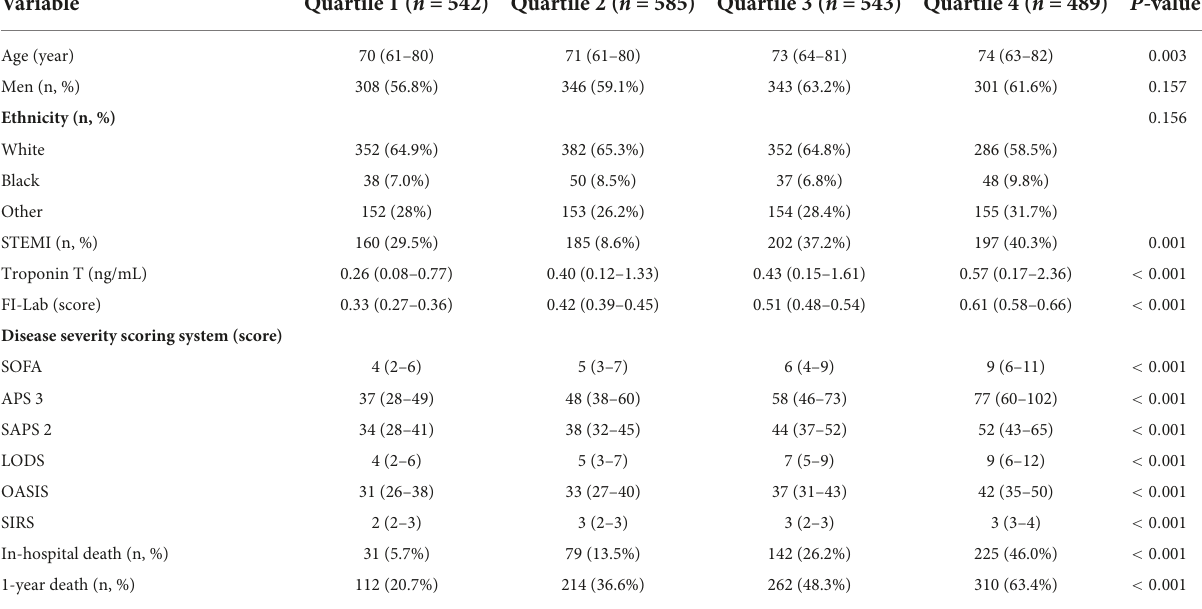
TABLE 1 Baseline characteristics of included patients according to frailty index based on laboratory tests (FI-Lab) levels ( n = 2,159).